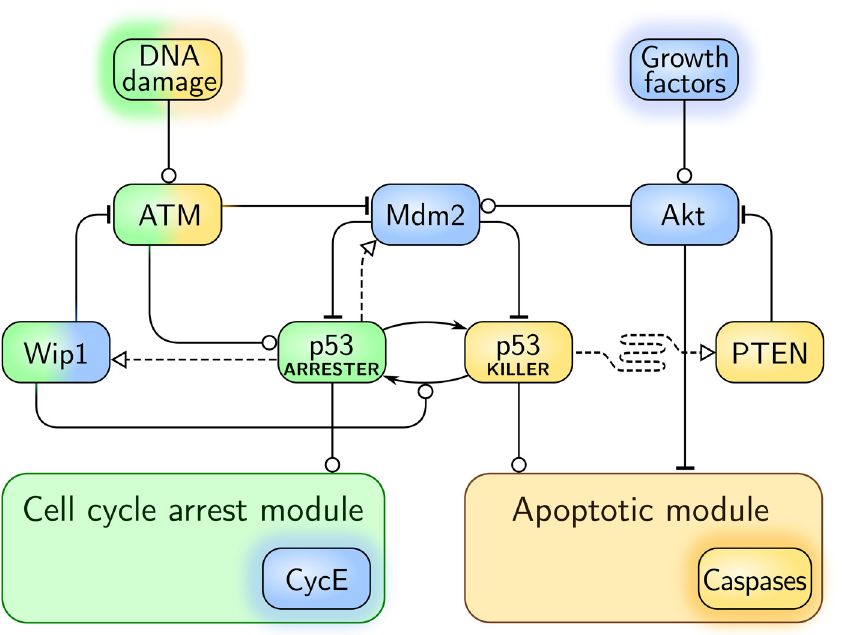
Fig 1. Simplified scheme of the model. Arrow-headed dashed lines indicate positive transcriptional regulation, arrow-headed solid lines — protein transformation, circle-headed solid lines — positive influence or activation, hammer-headed solid lines — inhibitory regulation. Pro-survival and cell cycle-promoting proteins are represented with blue boxes, pro-apoptotic proteins with yellow boxes, proteins involved in cell cycle arrest with green boxes. Details of the cell cycle arrest module and the apoptotic module are shown in Figs 2 and 3 respectively.